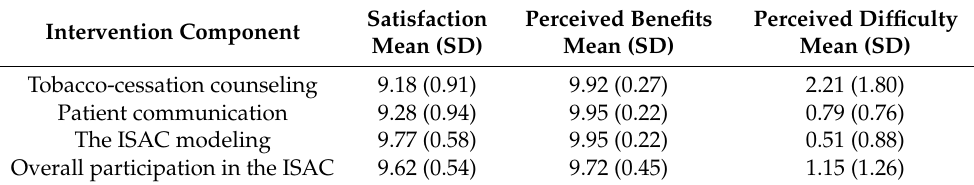
Table 2. Perceived satisfaction, perceived benefits, and perceived difficulty of the ISAC components ( n =